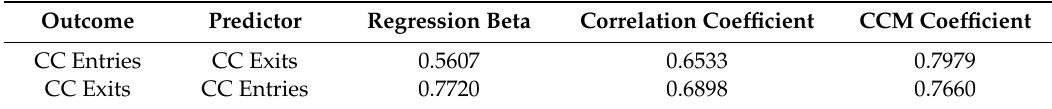
Table 2. CCM coefficients in congregate care entry and exit time